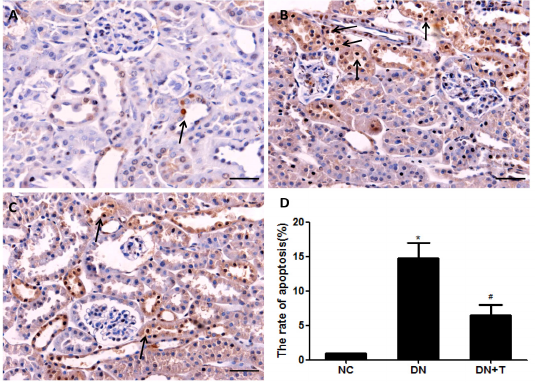
Figure 6. Effect of TUDCA on apoptotic tubular cells in renal tissues of db/db mice treated with TUDCA for eight consecutive weeks. Apoptosis of tubular cells in kidneys of each group: ( A ) non-diabetic db/m mice, NC group; ( B ) diabetic db/db mice, DN group; ( C ) diabetic db/db mice + TUDCA, DN+T group, were determined by TUNEL assay. Scale bar = 50 µ m. TUNEL-positive cells in renal tubules were presented by arrows; ( D ) Quantitative analysis of TUNEL-positive stained tubular cells. Values are presented as means ± SEM for 10 non-overlapping fields of each section and eight mice per group. * p < 0.05 versus NC group. # p < 0.05 versus DN group.